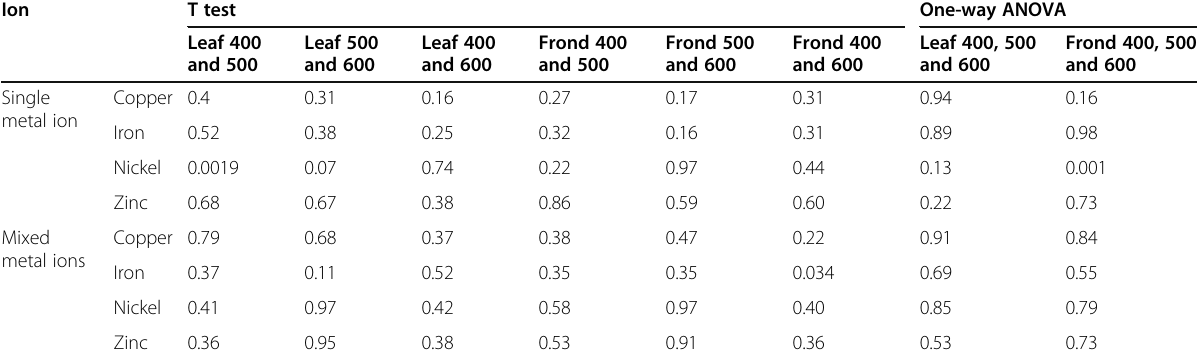
Table 5 T test and one-way ANOVA p values comparing different pyrolysis temperatures for biochar samples Ion T test